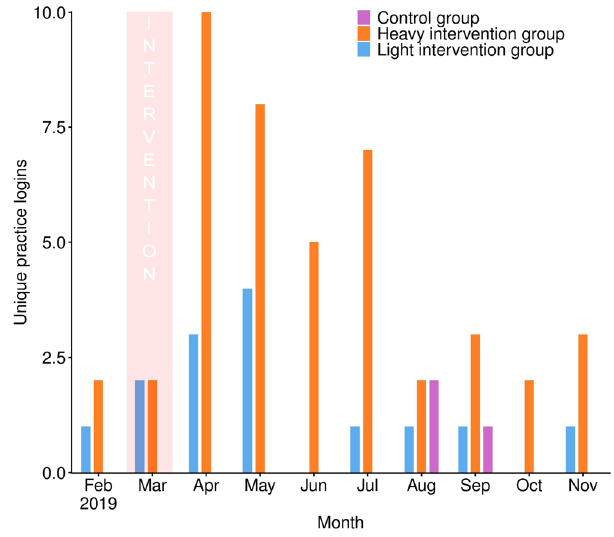
Fig. 4 SAVSNET antimicrobial prescription benchmarking portal engagement. Number of practices logging into the SAVSNET antimicrobial prescription benchmarking portal by month (February – November 2019 inclusive) and intervention group. The purple boxes refer to fi ndings from the control group ( n = 20 practices); the blue boxes refer to the light intervention group ( n = 20 practices), and the green orange boxes refer to the heavy intervention group (HIG, n = 20 practices). The pink shaded region shows the month at which the initial noti fi cation took